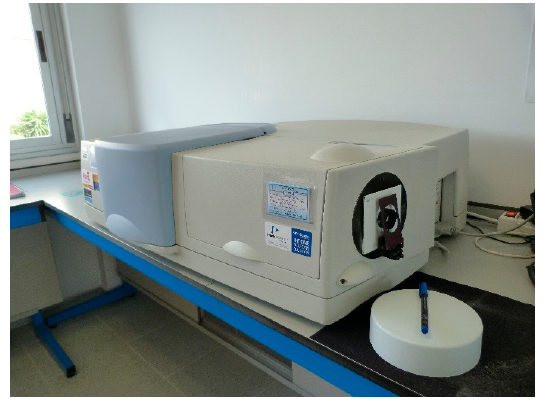
Figure 3. Spectrophotometer Lambda 1050 by Perkin Elmer (PE).